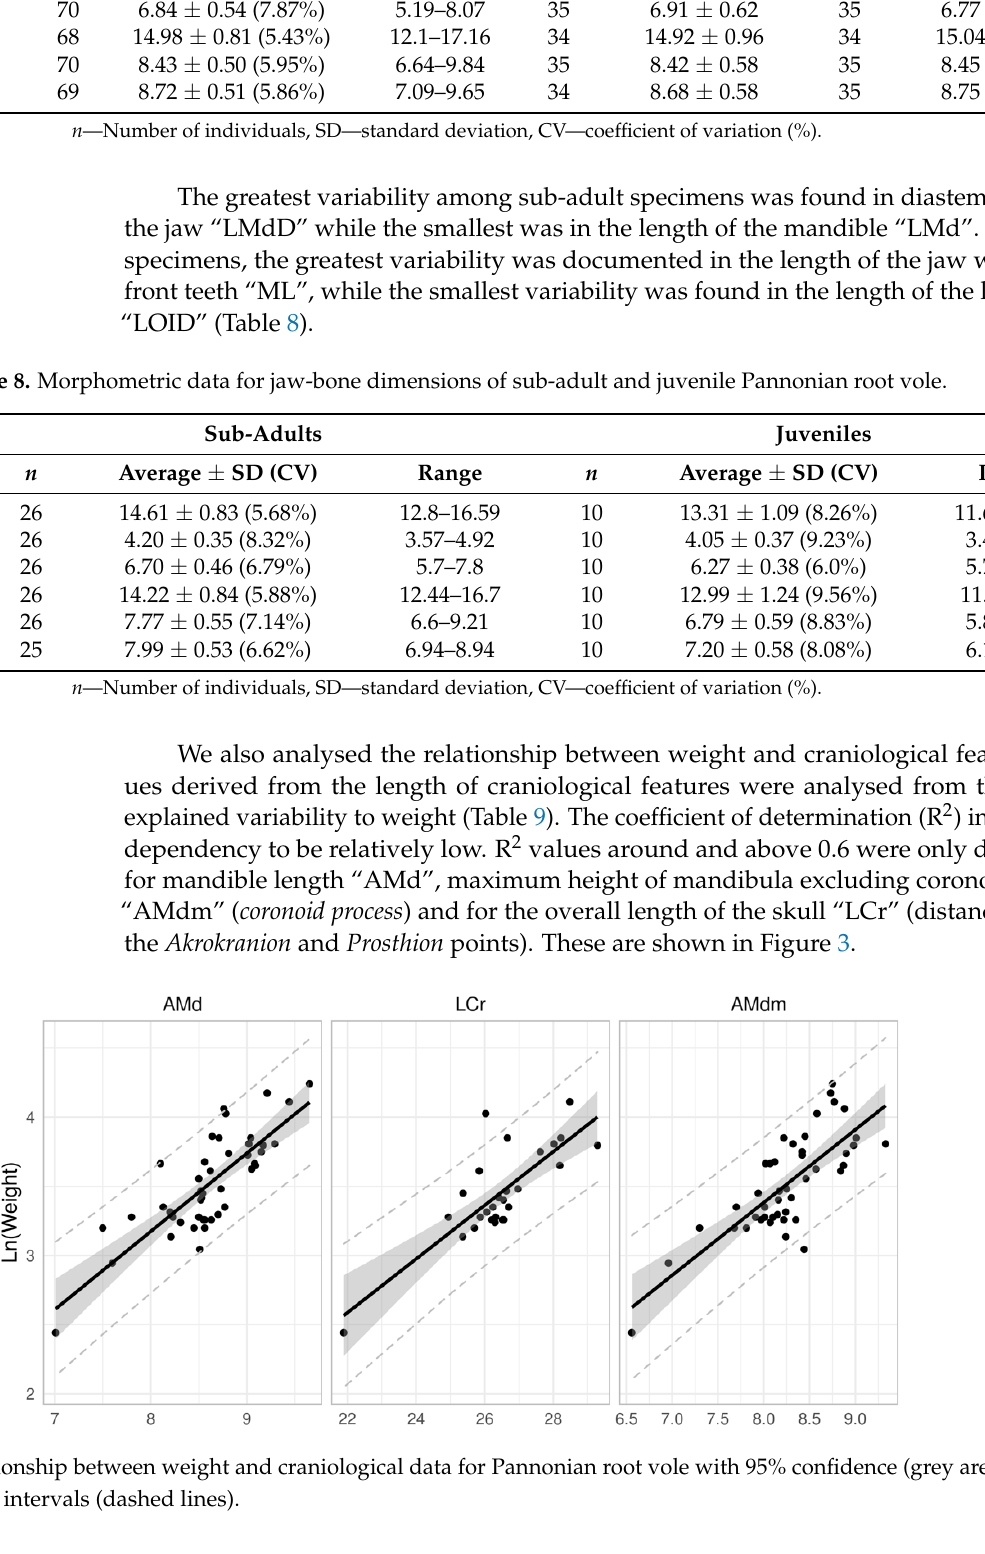
Table 9. Craniological features ordered by ratio of explained variability to the log-transformed weight of Pannonian root vole. To predict weight, use: e α + β * x where x is measured variable value.